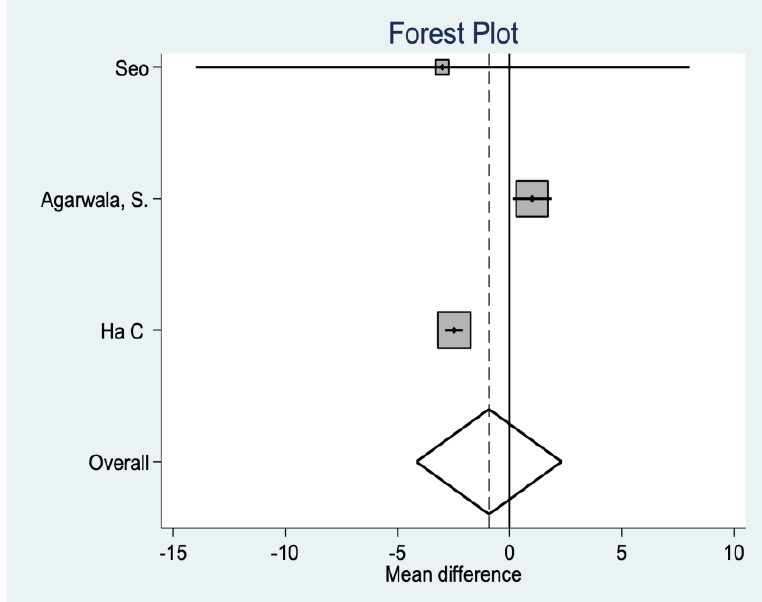
Figure 9. Radiological variable data.